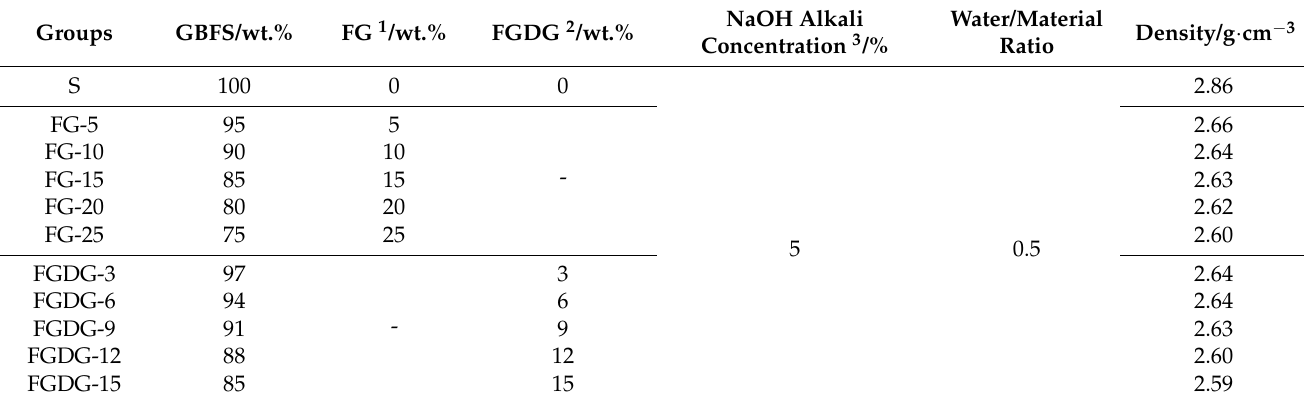
Table 4. The design of mix proportions of cement